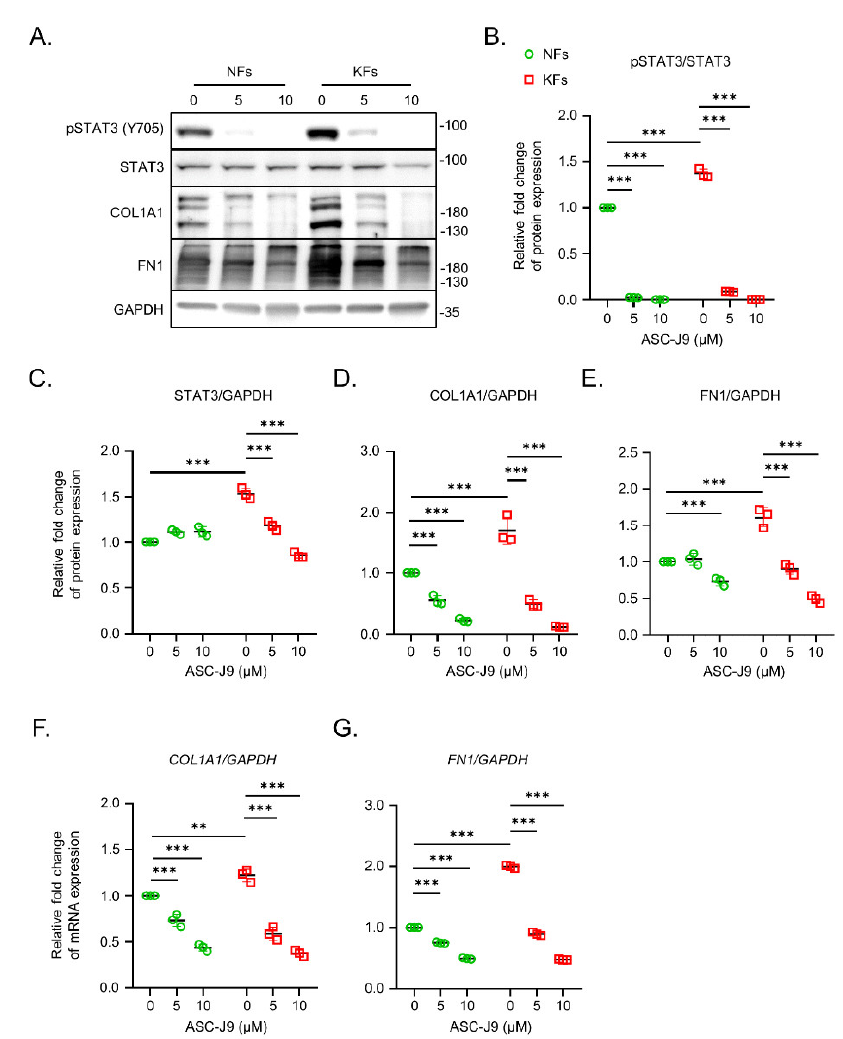
Figure 1. The blockage of ASC-J9 in extracellular matrix synthesis of normal fibroblasts and keloid fibroblasts. ( A ) The protein levels of pSTAT3 (Y705), STAT3, COL1A1, FN1, and GAPDH in NFs ( n = 3) and KFs ( n = 3) treated with ASC-J9 at various concentrations were examined by Western blotting. ( B – E ) The intensity of pSTAT3 expression relative to STAT3 was calculated on the basis of the results of Western blotting. The intensity of STAT3, COL1A1, and FN1 expression relative to GAPDH was also quantified. The relative fold change in protein expression in each group was normalized to that in NFs without ASC-J9 treatment. ( F , G ) The mRNA levels of COL1A1 and FN1 in NFs ( n = 3) and KFs ( n = 3) treated with 0, 5, or 10 μM ASC-J9 for 24 h, detected by qPCR. The relative fold change of mRNA expression in each group was normalized to that in NFs without ASC-J9 treatment. NFs, normal fibroblasts; KFs, keloid fibroblasts. ** p < 0.01, *** p < 0.001. p -values were determined by two-way analysis of variance.